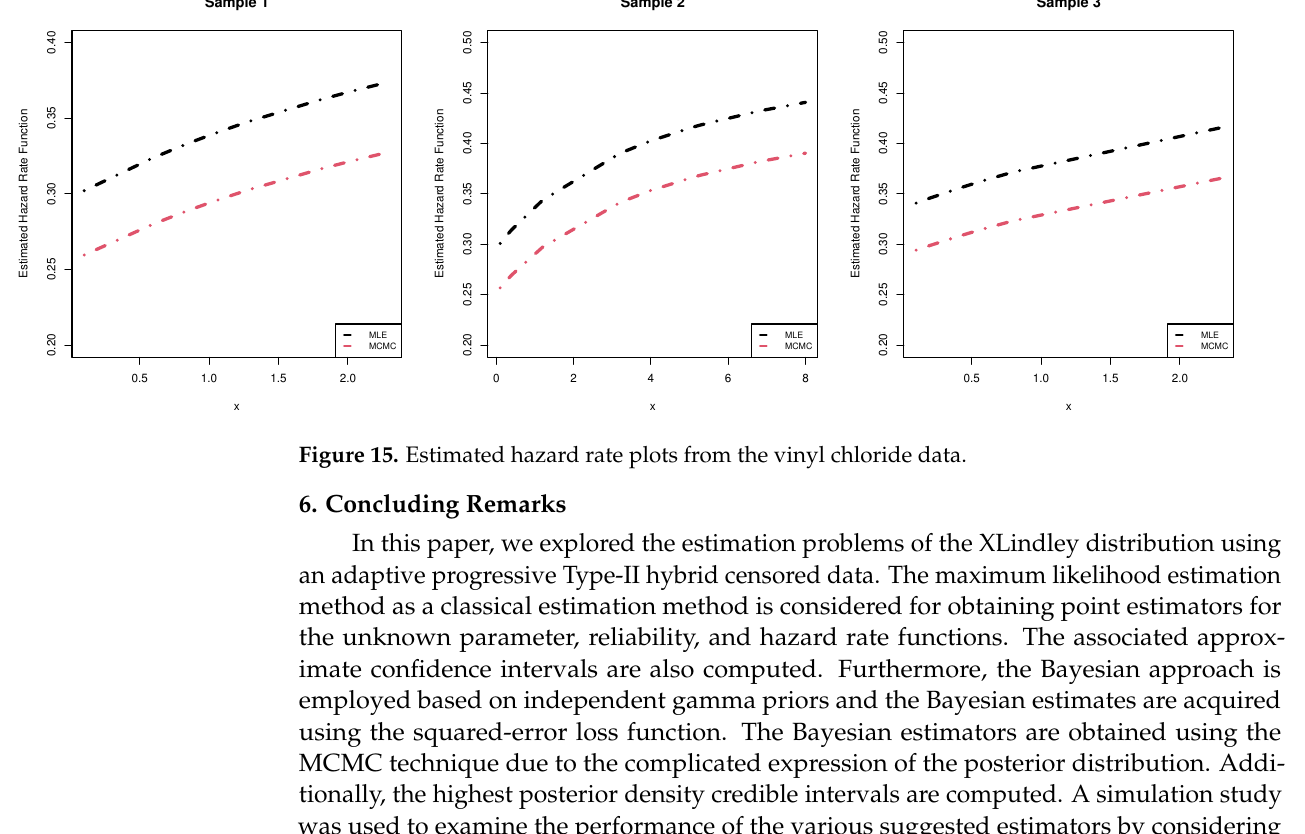
Table S8: The ACLs (first-column) and CPs (second-column) of ACI/HPD credible intervals of λ when λ = 1.5; Table S9: The ACLs (first-column) and CPs (second-column) of ACI/HPD credible